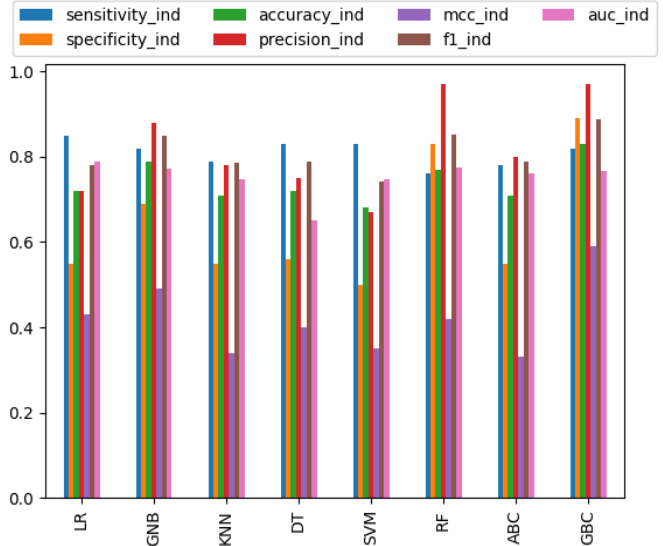
Figure 2. Performance measures for different machine learning methods using the independent dataset and the AAC and DPC features.